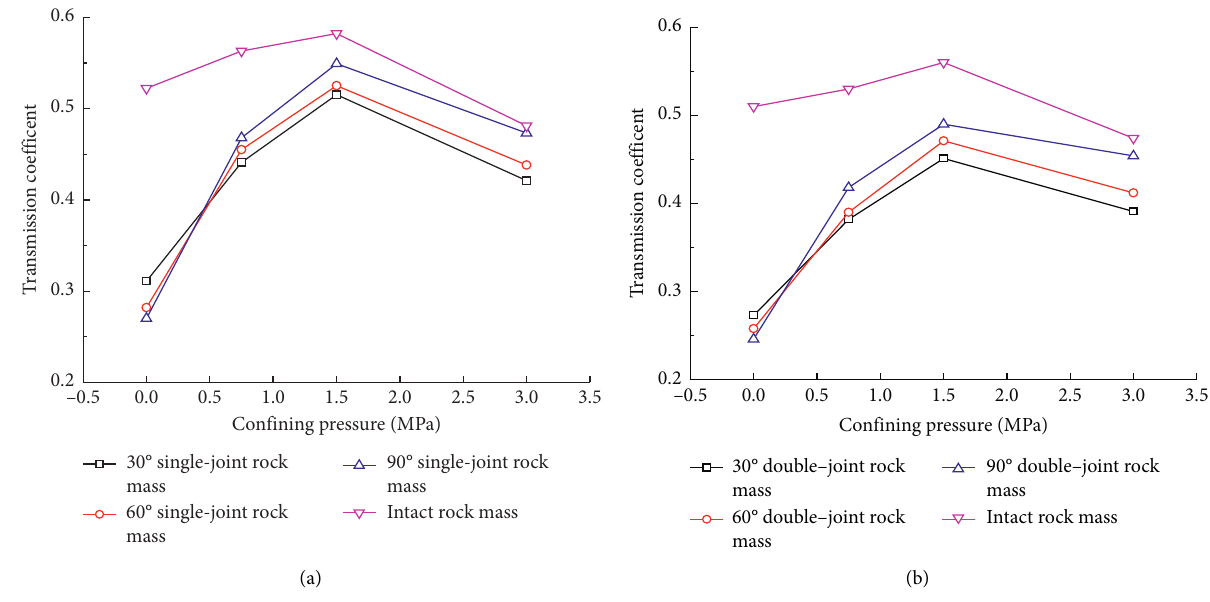
Figure 22: Variation law of transmission coefficient of intact and jointed rock mass under different confining pressures. (a) T1. (b)